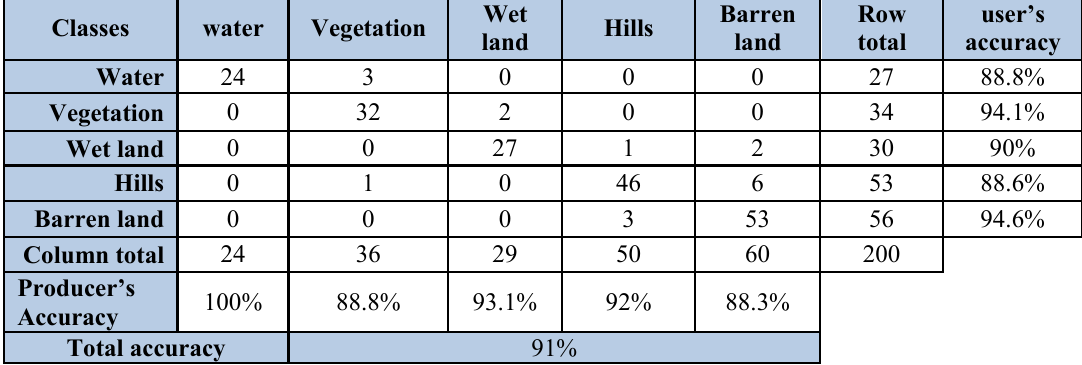
Table 7: Error matrix with producers, users, and overall accuracy calculations for unsupervised classification using mean value for Landsat-8 (2014).